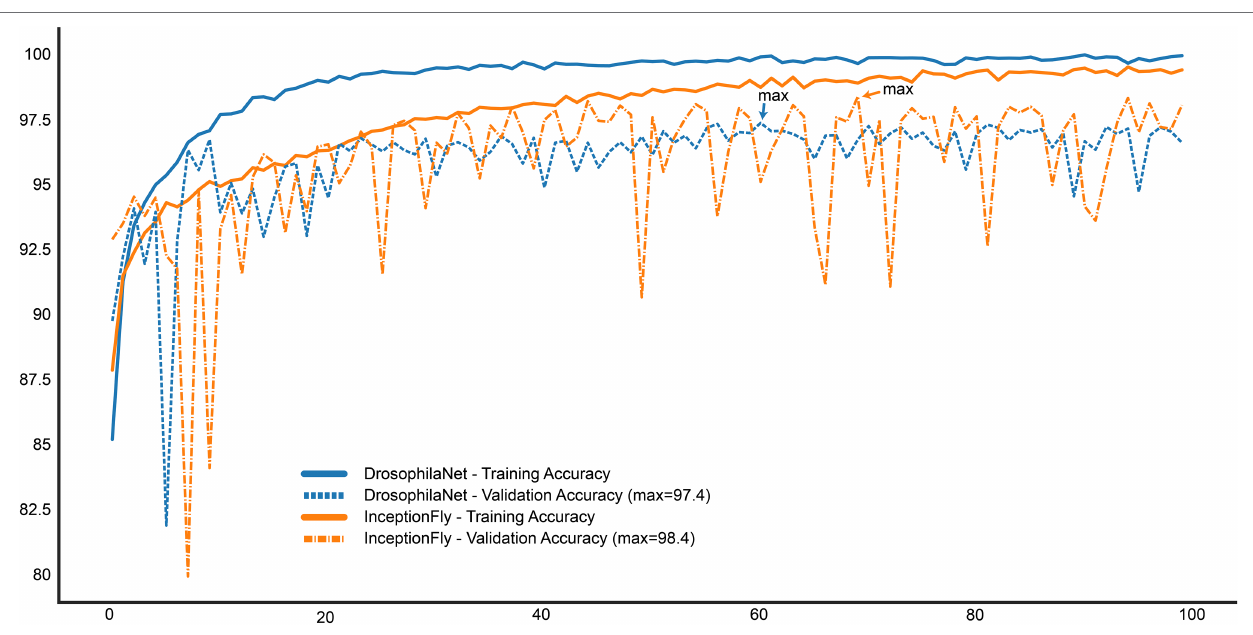
FIGURE 9 | Training and Validation accuracy curves for the top two performing models: InceptionFly and DrosophilaTime.